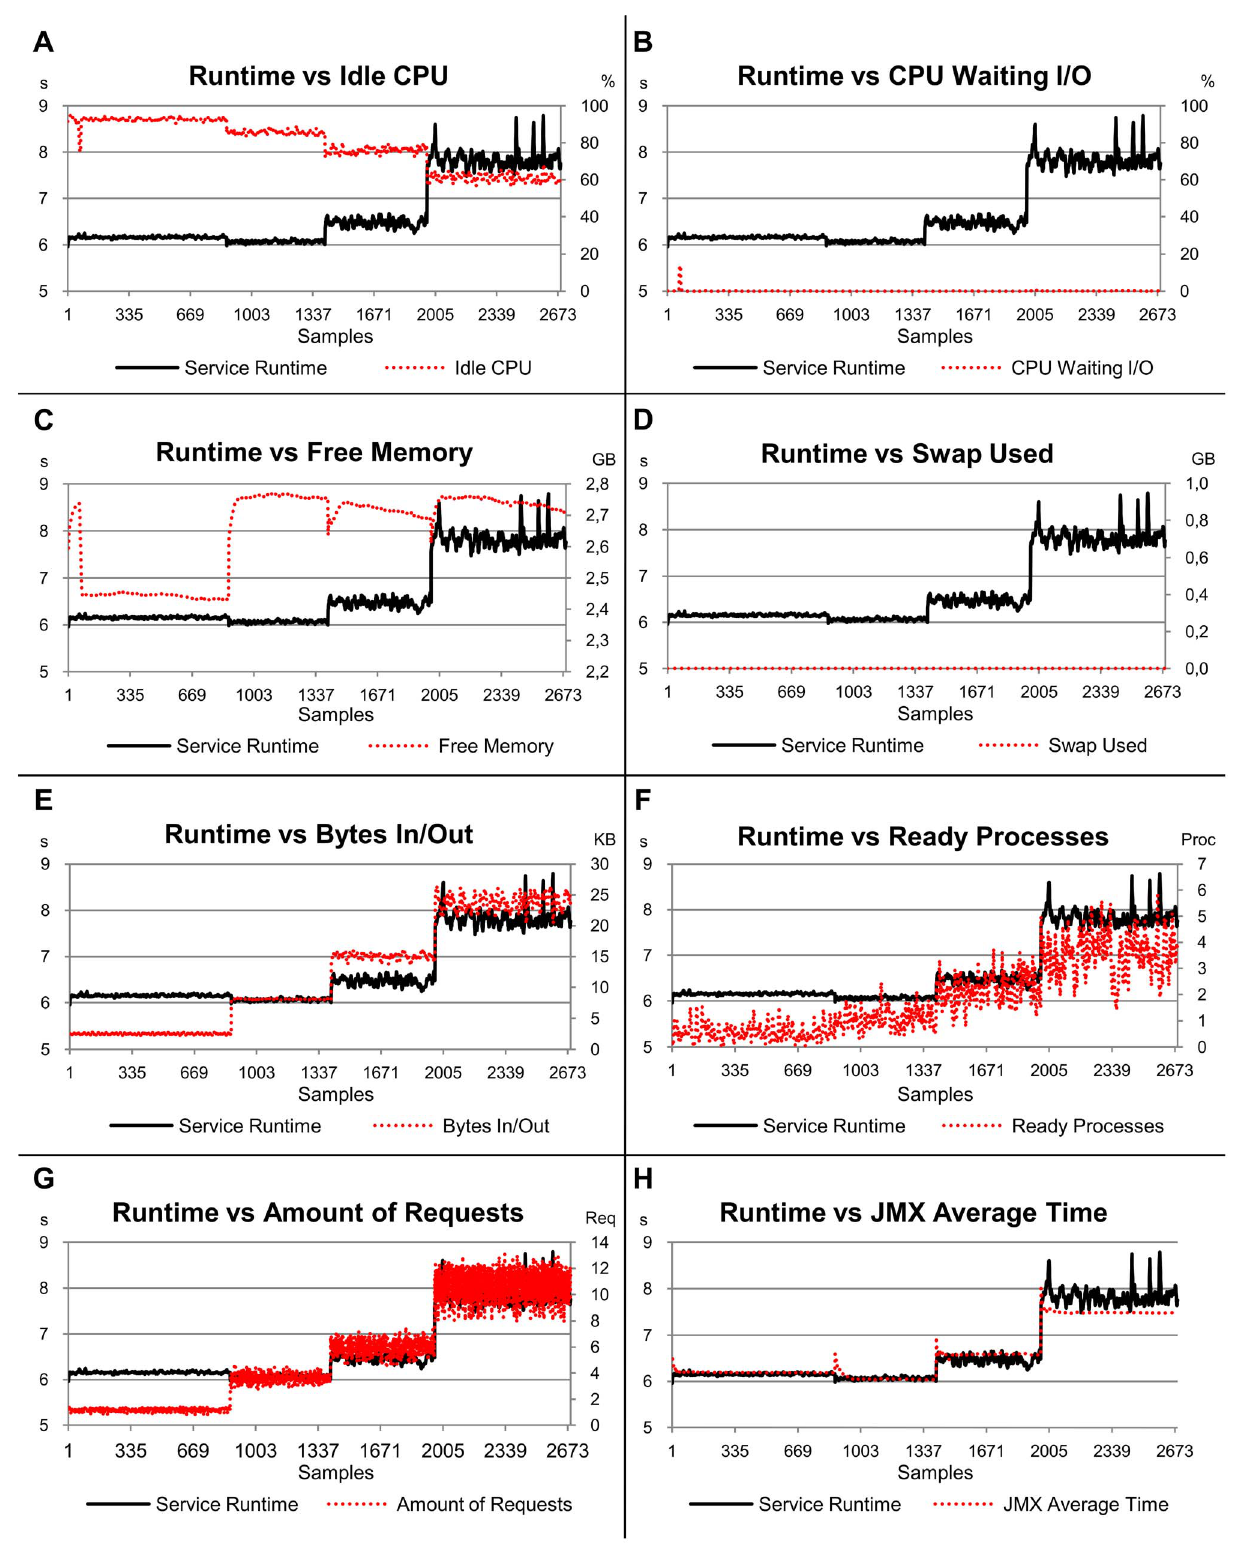
Figure 5. Relation of the service runtime versus eight load indices, considering the third scenario (database-bound service). The left- hand scale of the y-axis always represents the service runtimes in seconds (s). The right-hand scale of the y-axis, where necessary, represents the metric used by the load index. The x-axis represents the samples collected every 10 s by Ganglia and JMX while the benchmarks were requesting services for the server.